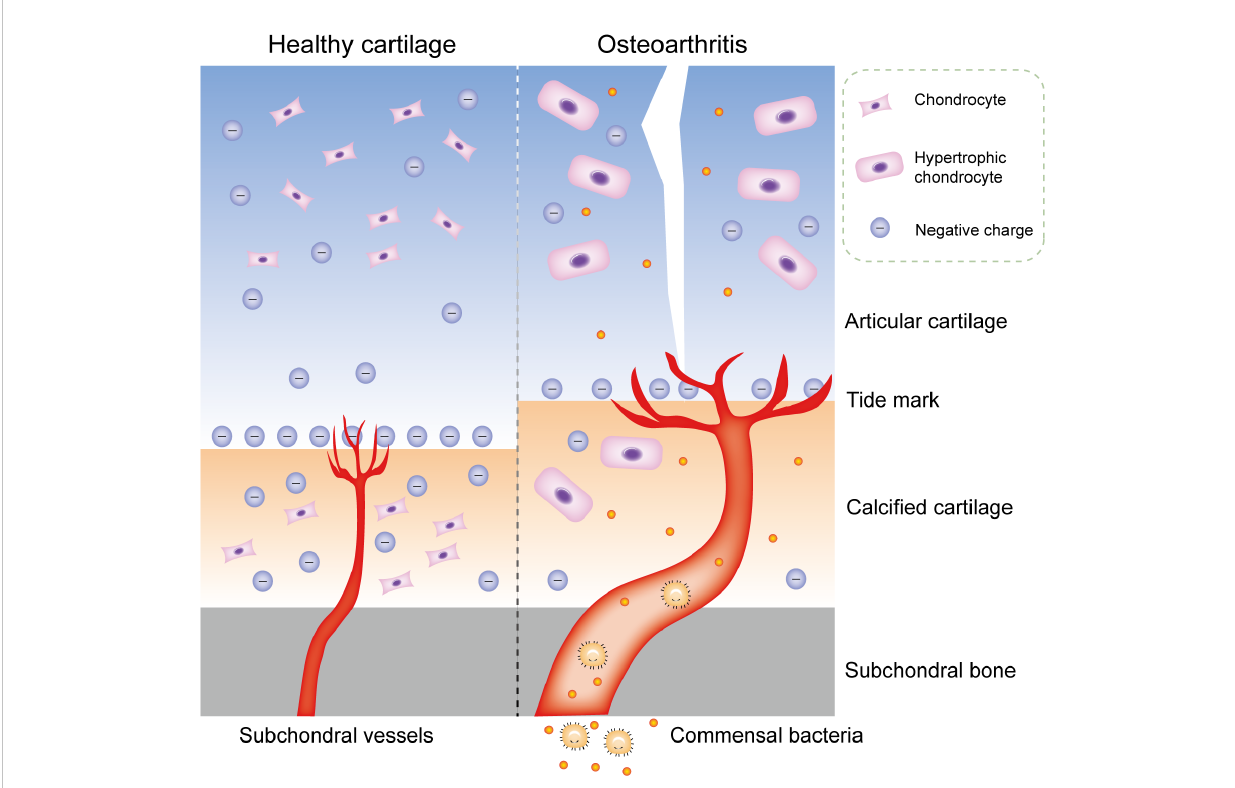
FIGURE 4 Commensal bacterial components may transfer to cartilage in OA. Physiologically, the microstructure of cartilage matrix limits substance transport through pore size, charge, and molecular con fi guration. During OA, there are more blood vessels and thickened tube diameters in calci fi ed cartilage zones, which allows commensal bacterial components of the blood to transfer to calci fi ed cartilage and subchondral bone, and even to enter normal chondrocytes through tiny cracks in the tide mark. OA,